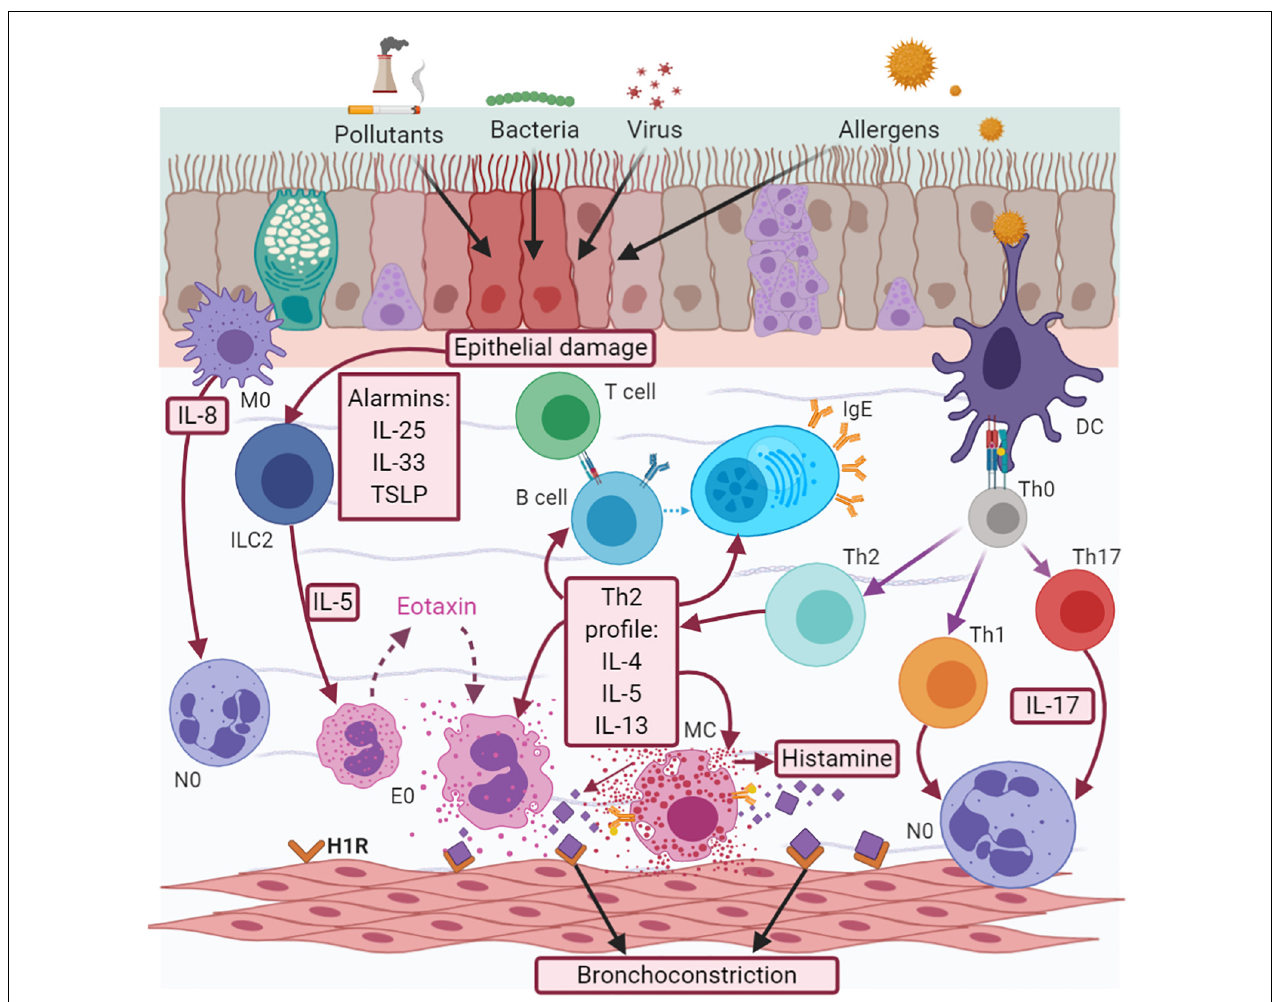
FIGURE 1 | Asthma pathophysiology. Asthma is a complex interaction between cells, cytokines and chemokines. There are two effector cell responses, neutrophilic, and eosinophilic. The eosinophilic response is the most frequent, mediated by the synthesis of a Th2 cytokine profile (IL-5, IL-4, and IL-13) and histamine released when there is an IgE-mediated allergic response; or by alarmins (TSLP, IL-25, and IL-33) in the case of a non-allergic one. Neutrophilic response is less understood and maybe a transition from early Th2 or be a consequence of early Th1/Th17 secondary to macrophage activation and IL-8